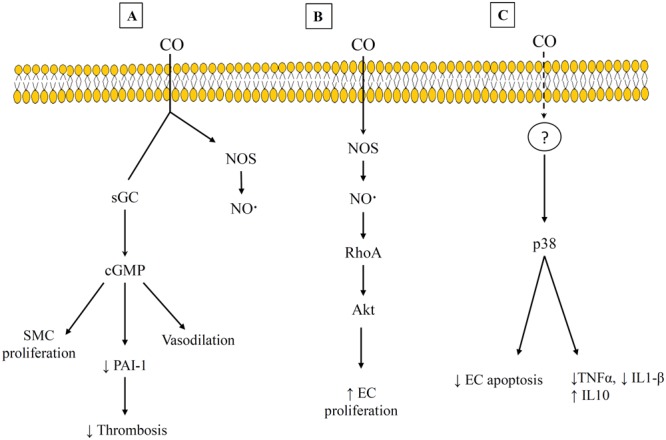
Examples of carbon monoxide (CO) Pathways and heme-binding targets. (A) cGMP-dependent pathway that leads to suppression of SMC and decrease thrombosis. (B) CO interacts with RhoA and Akt to promote EC proliferation. (C) A p38 mitogen activated pathway that exhibits anti-inflammatory effects. References for this figure are listed in the text.